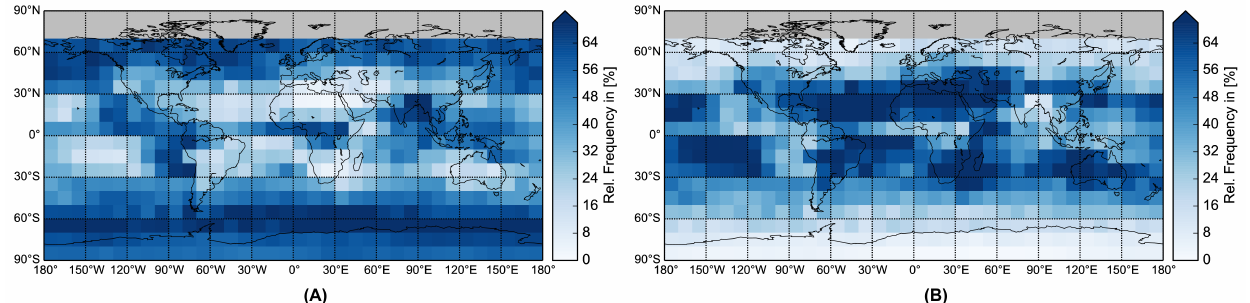
Figure 2. Relative frequencies of clouds (CAD ≥ 70) ( A ) and aerosols (CAD ≤ –70); ( B ) for August 2006–2013.